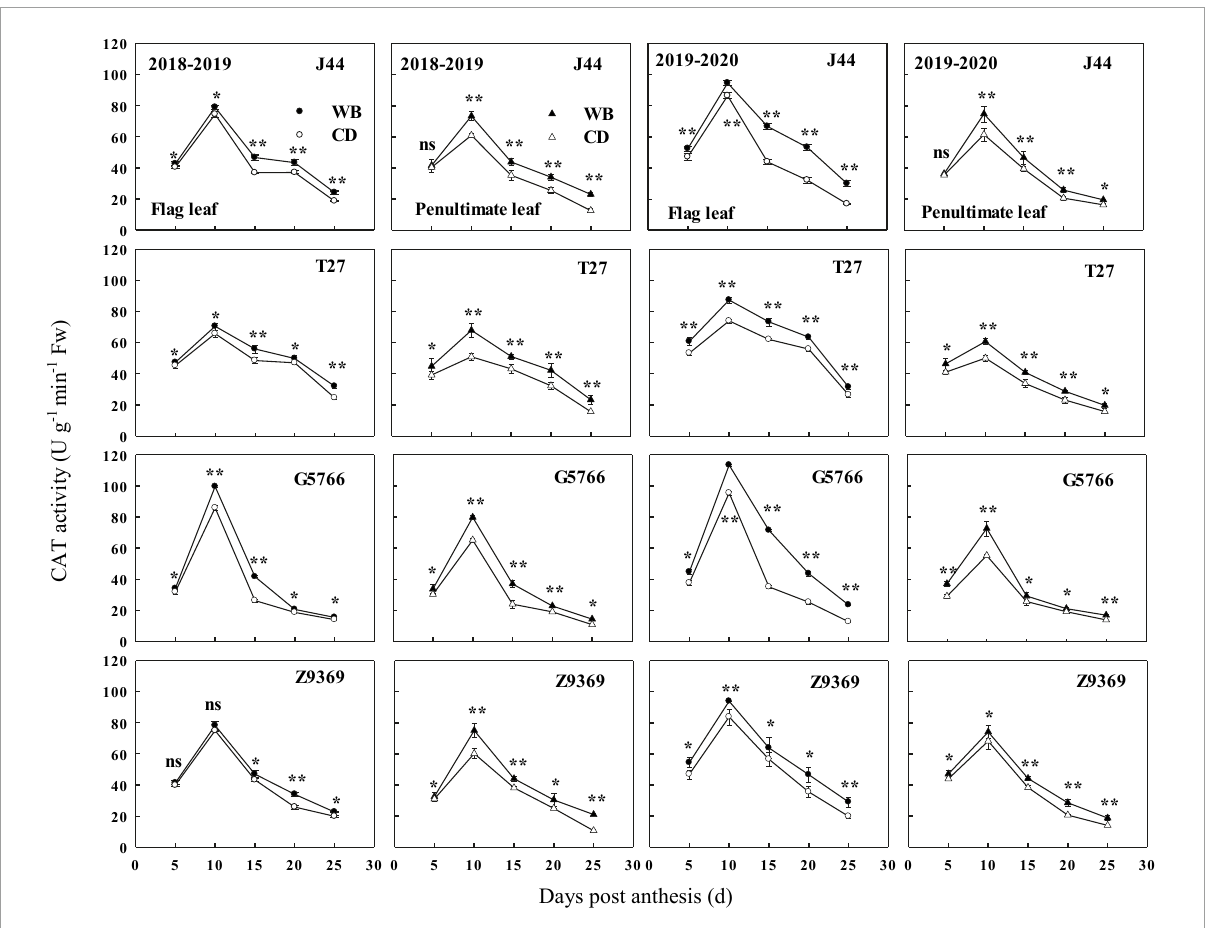
FIGURE9 Effects of sowing pattern on catalase (CAT) activities of the flag leaf and penultimate leaf of bread wheat. Values are means of three replicates per treatment. Vertical bars indicate standard error. ns, *, and **Indicate significant differences at P ≥ 0.05, P < 0.05, and P < 0.01 between the two sowing patterns at each measurement time. CD and WB denote the conventional drilling and wide belt sowing pattern,